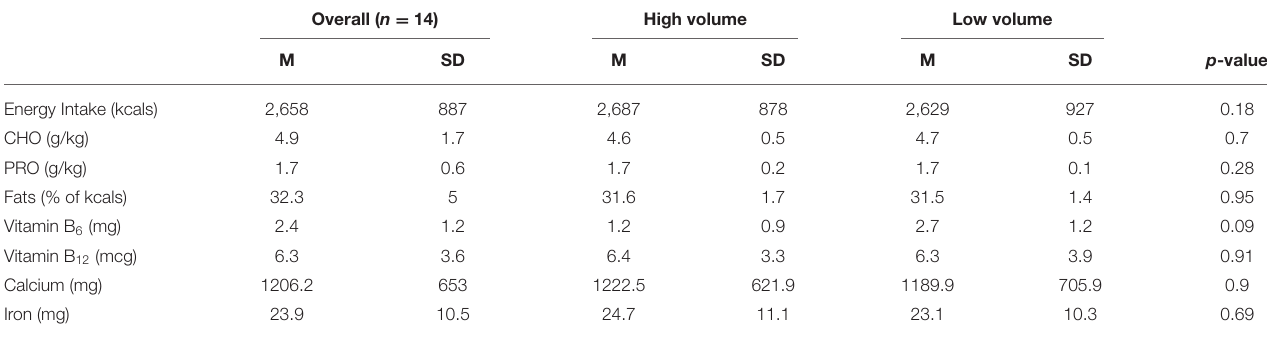
TABLE 5 | Daily energy, macro and micronutrient intake in the high- and low-volume training weeks ( n = 14). Overall ( n = 14) High volume Low volume M SD M SD M SD p -value Energy Intake (kcals)